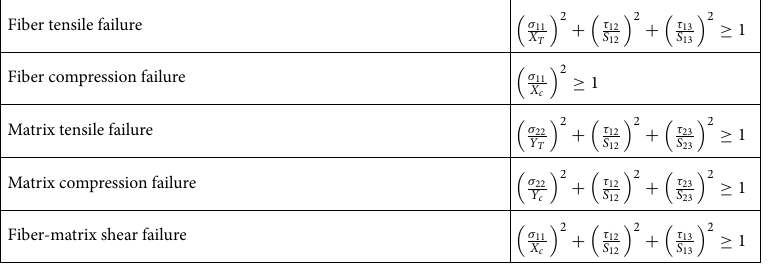
Table 4. Hashin failure criteria. Where σ 11 , σ 22 is the normal stress and τ 12 , τ 13 , τ 23 is the shear stress in three directions respectively; X T , X C is the longitudinal tensile and compressive strength, Y T , Y C is the transverse tensile and compressive strength, and S ij is the in-plane shear